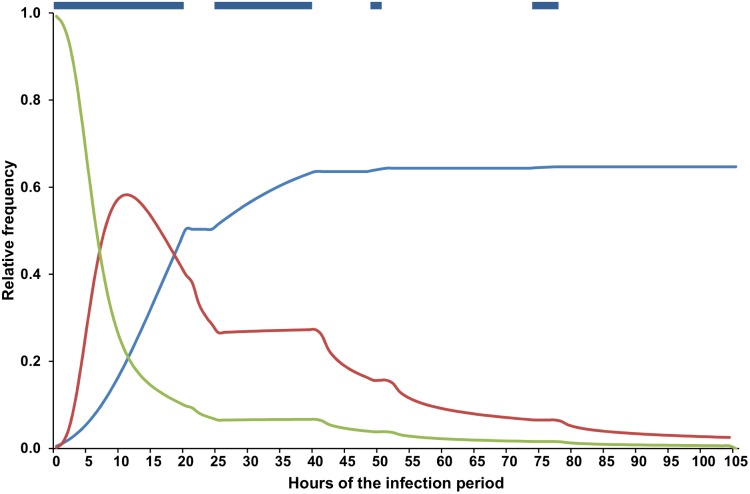
Dynamics of lesion units (LUs) during an infection period of Fusicladium eriobotryae.The graph shows the relative frequency of LUs occupied by ungerminated conidia (LUUC, in green), germinated conidia (LUGC, in red), and latent infections (LULI in blue). Blue bars at the top indicate hours with free water on the fruit surface. An infection period starts when a rain event splashes conidia on LUs and ends when no viable conidia are present on any LUs, i.e., when LUUC≤0.01.